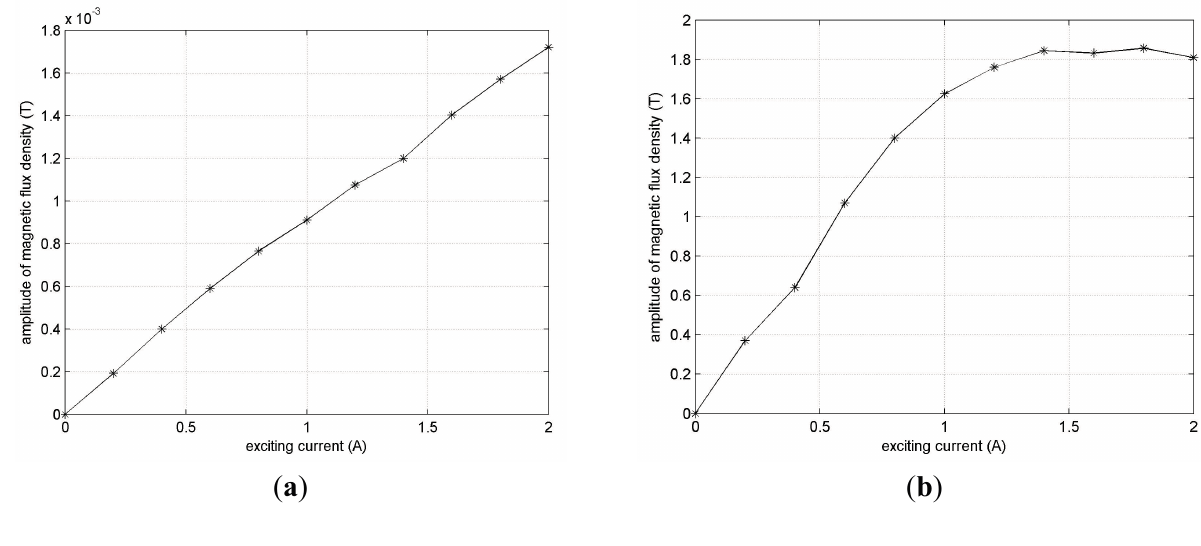
Figure 15. Influence of exciting currents. ( a ) Simulation; ( b )